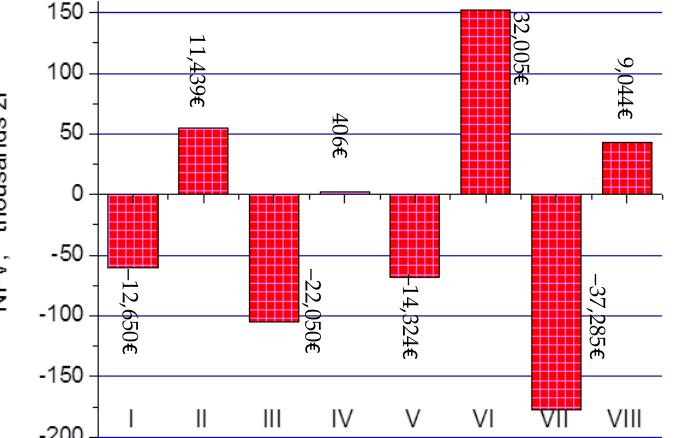
Figure 5. Net present value in thousands PLN (and in thousands EUR) for each option analyzed (methods I to VIII according to Table